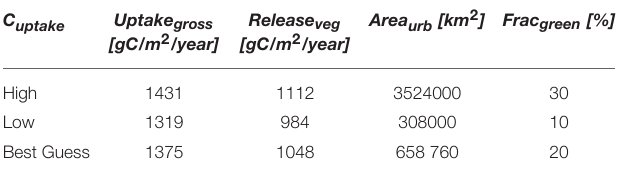
TABLE 1 | Values used to estimate high, low, and best guess of gross carbon uptake and release from urban vegetation and soil respiration